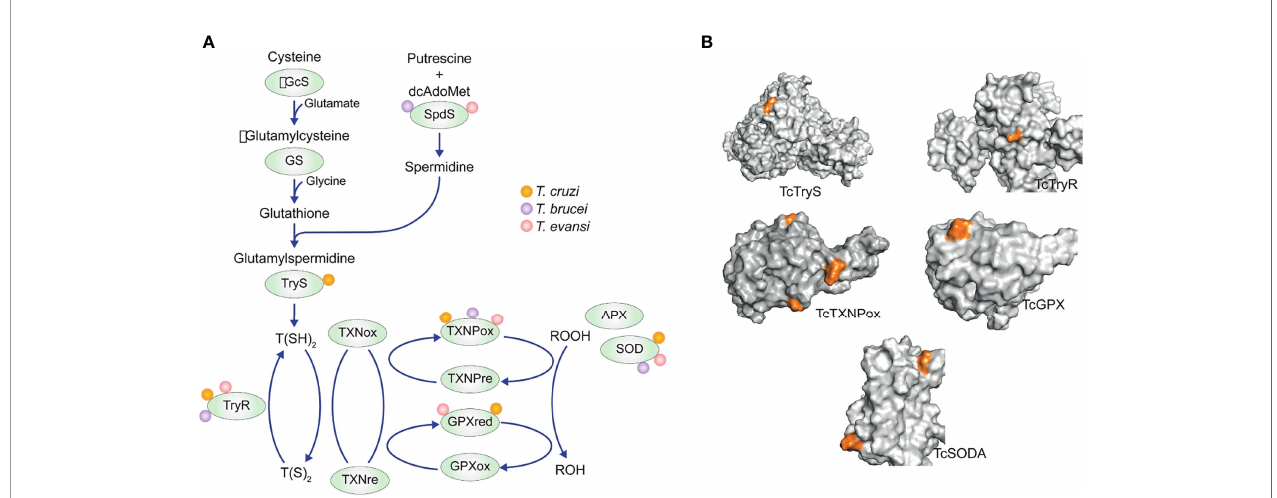
FIGURE 8 | Antioxidant enzyme acetylation detected in T. cruzi , T. brucei , and T. evansi acetylomes. (A) Enzymes belonging to the tree main antioxidant pathways of trypanosomatids with one or more acetylation lysine sites. (B) Distribution of lysine-acetylated sites (orange) in the 3D protein structure of the fi ve T. cruzi antioxidant enzymes detected in the acetylome of the